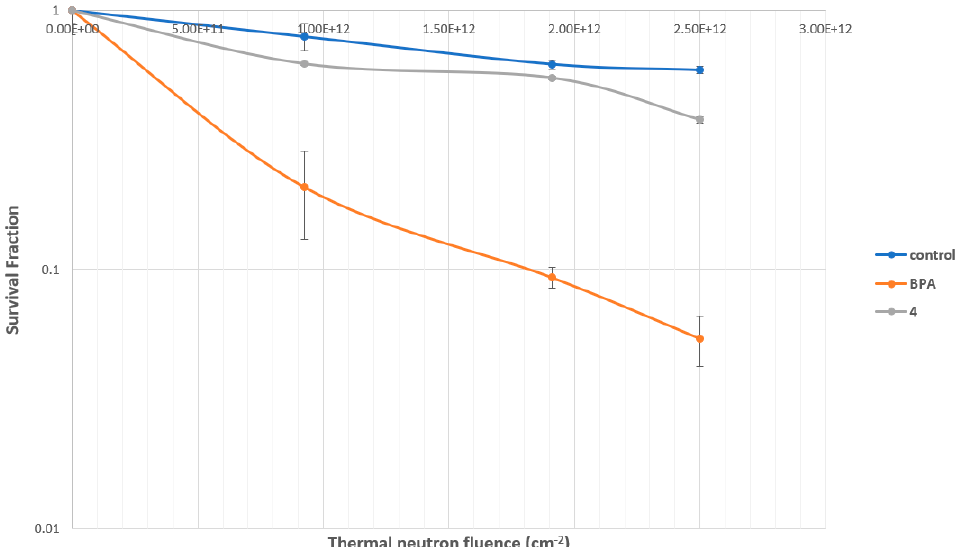
Figure 9. Survival fraction in SCC VII cells. BPA: 20 ppm 10 B; compound 4 : 0.48 ppm 10 B treated with SCC VII cells for 4 h.